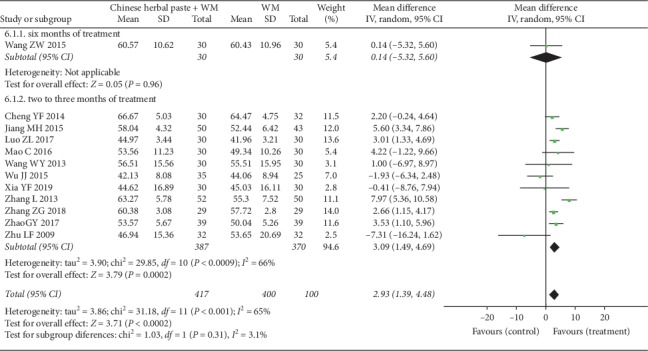
Forest plot of FEV1%pred.